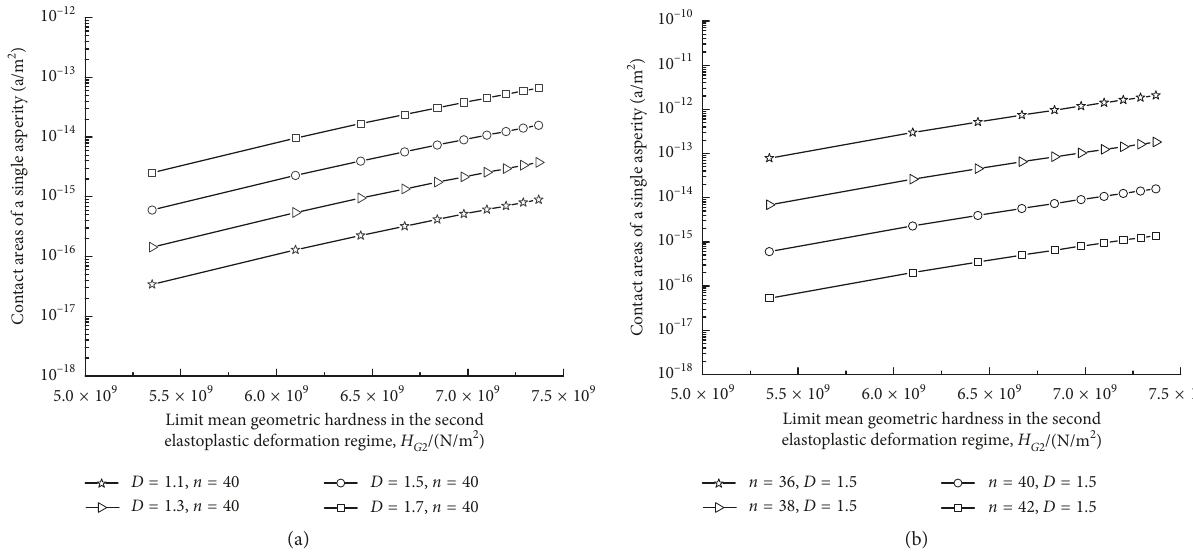
Figure 7: The relationship between limit mean geometric hardness and contact for single asperity during the second elastoplastic de- formation stage. (a) n � 40 , 1 . 1 ≤ D ≤ 1 . 7. (b) D � 1 . 5 , 36 ≤ n ≤